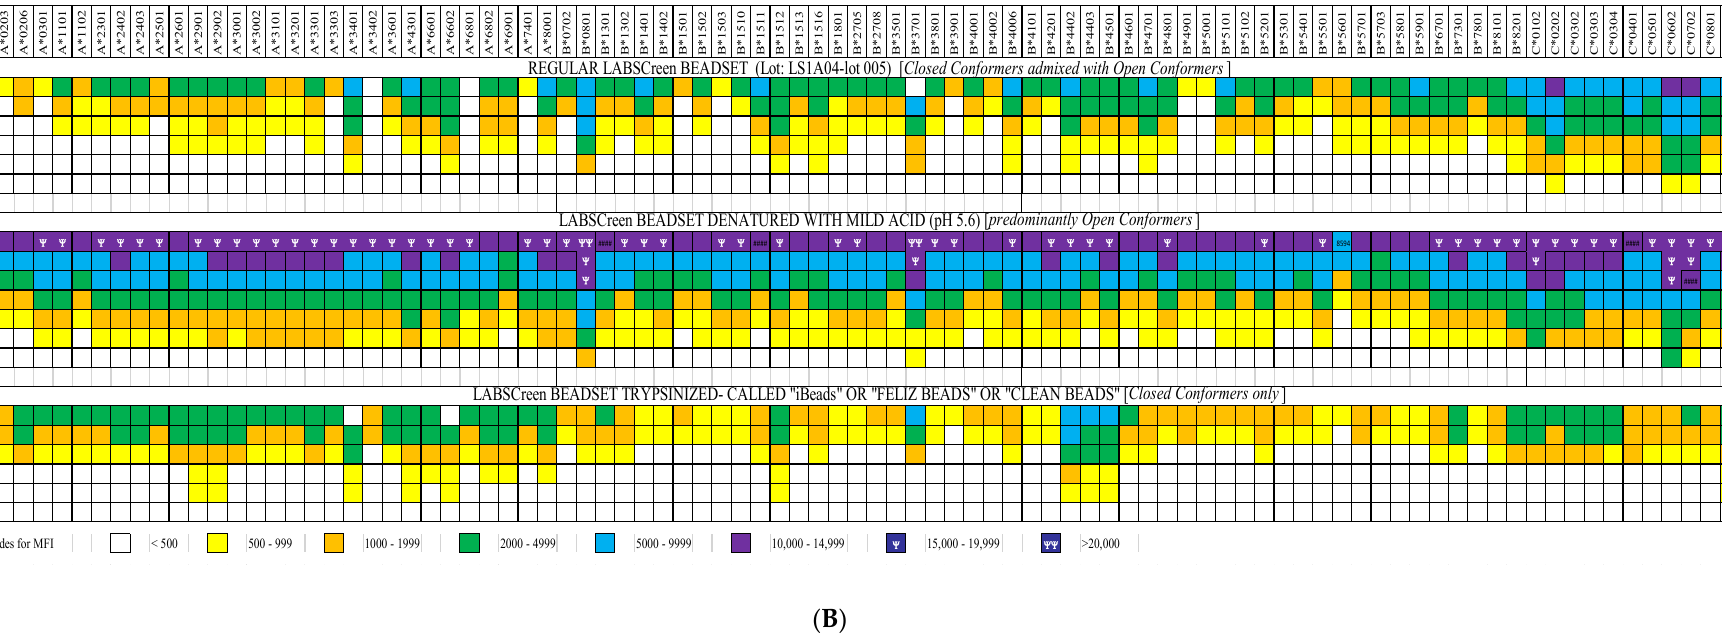
Figure 5. HLA-I polyreactivity of IVIg. IVIg was tested on three kinds of SABs: (i) regular LABScreen bead set coated with an admixture of CCs and OCs, (ii) regular LABScreen bead set treated with a mild acid to convert OCs to CCs. The bead set was loaded with OCs. (iii) “iBeads” generated from regular LABScreen bead sets to enzymatically eliminate OCs, and therefore containing only CCs. The Luminex immunoassay with IVIg from GammaSTAN ( A ) and Octagam ( B ) confirmed the HLA-I polyreactivity of IVIg. Importantly, IVIG reacted with the monomeric variants on the acid-denatured SABs better than on iBeads. The density of IgG binding is illustrated by mean fluorescent intensity (MFI), as shown in different colors. The binding affinity of IVIg to monomeric variants was much higher than those recognizing the CC on ‘iBeads.’.